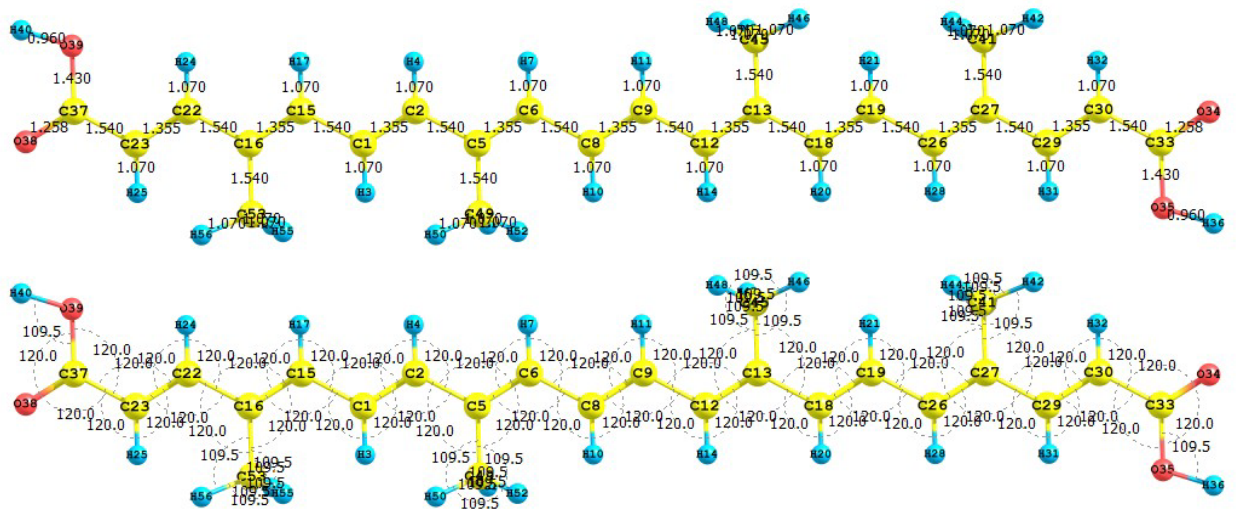
Figure 4. Interatomic bond distances ( Å ) and bond angles (deg) for the norbixin molecule.